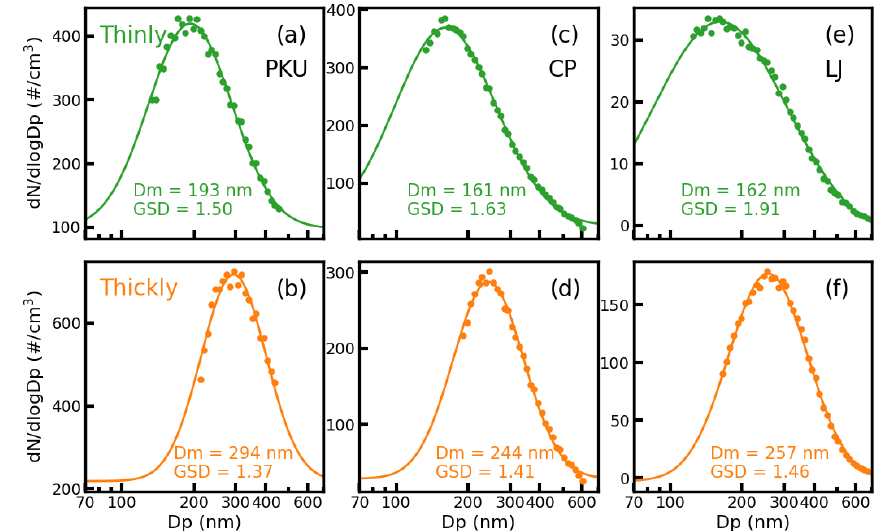
Figure 5. The number size distributions of the thinly coated BC-containing aerosols at (a) PKU, (c) CP, and (e) LJ sites. Panels (b) , (d) , and (f) are the number size distributions of the thickly coated BC-containing aerosols for the PKU, CP, and LJ sites, respectively. The dots in the figure are the measurement results and the lines are the corresponding fit results with a log-normal distribution. Table 1. The D me and GSD values of the BC core at different sites. Site Value Number distribution Mass distribution Thinly coated Thickly coated All Thinly coated Thickly coated All PKU D me (nm) 115 114 114 187 GSD